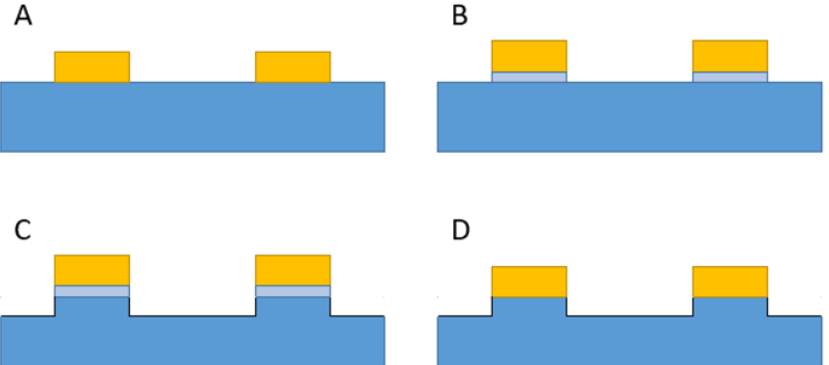
Figure 2. A cross-sectional view of lateral PCSS fabricated with ( A ) metal contacts, ( B ) a conductive GaN layer and metal contacts, ( C ) a conductive GaN layer and metal contacts with a mesa etched profile, ( D ) metal contacts with a mesa etched profile.